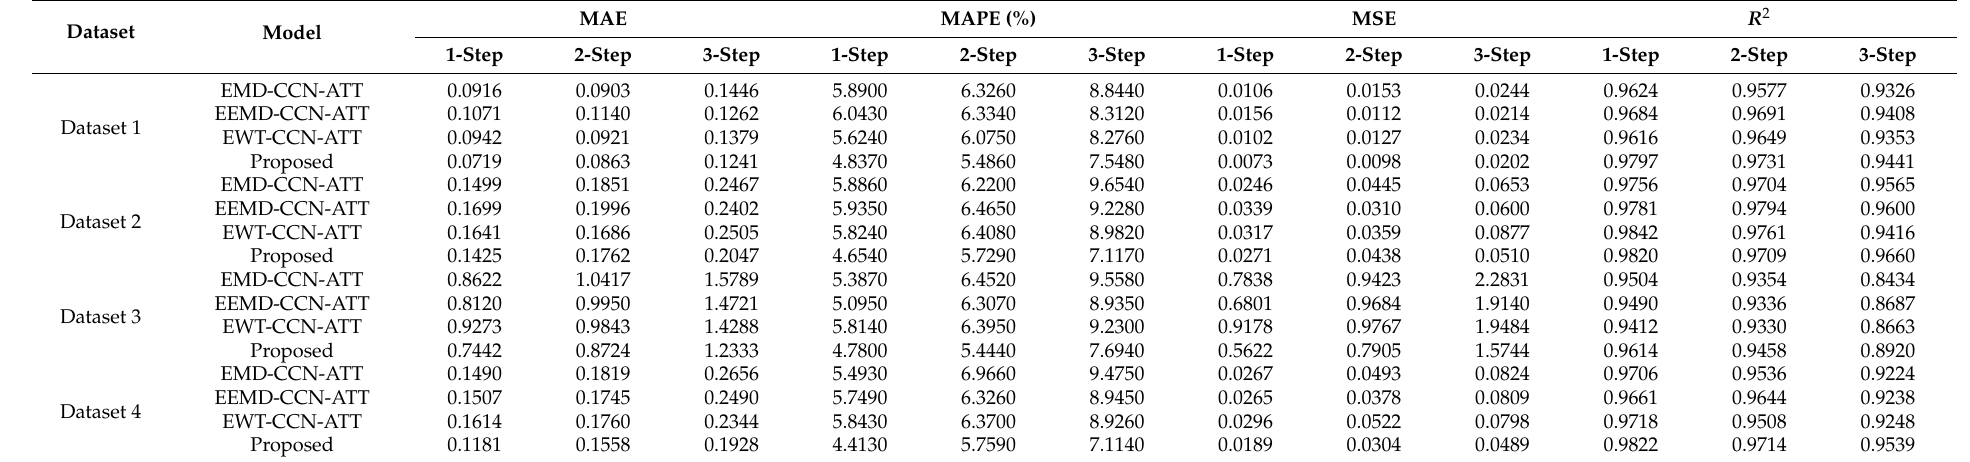
Table 6. Error evaluation results of models with different decomposition methods in four